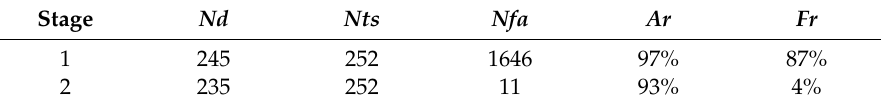
Table 1. Detection results of the proposed ship detection